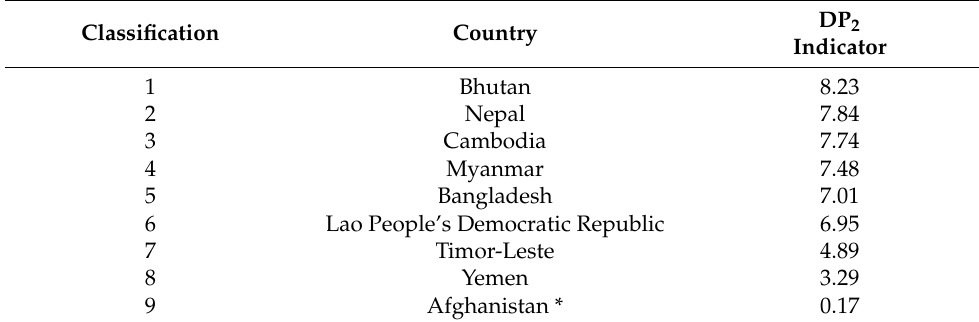
Table 1. Synthetic indicator of Sustainable Development Goal 3 (SDG3): Good Health and Wellbeing of the least developed countries (LDCs) of Asia for 2018. Countries in order of relative Pena Distance Method